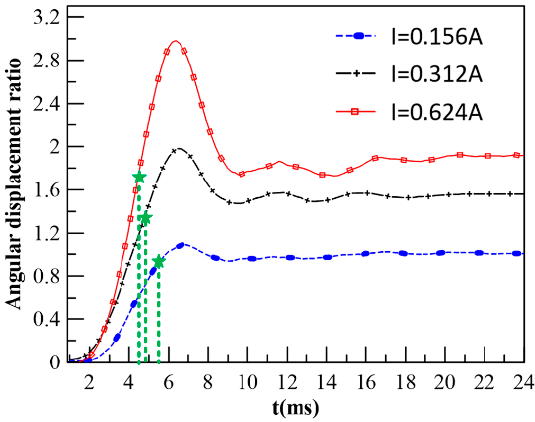
Figure 29. Step response characteristics.